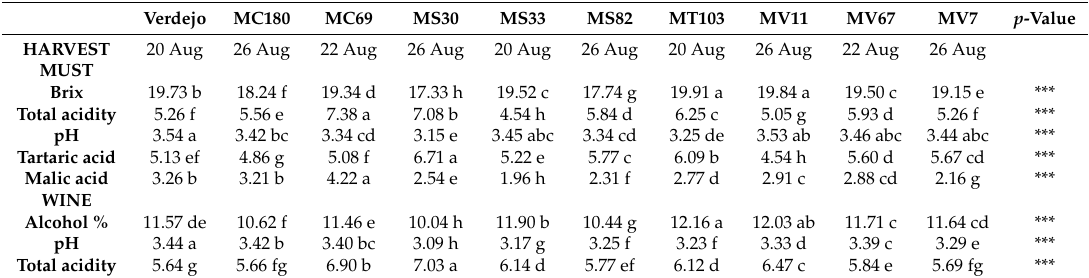
Table 2. Analytical parameters in must at harvest and in wine at the end of alcoholic fermentation in 2019